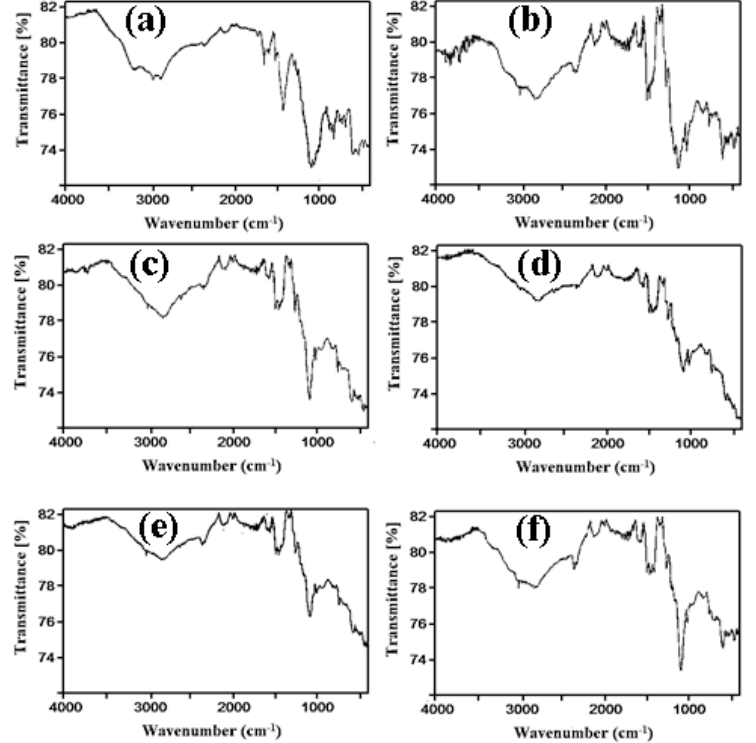
Figure 2. FTIR spectra of ( a ) pure POA, ( b ) 1% of POA/BaSO 4 , ( c ) 3% of POA/BaSO 4 , ( d ) 5% of POA/BaSO 4 , ( e ) 7% of POA/BaSO 4 , and ( f ) 10% of POA/BaSO 4 POA/BaSO 4 , ( e ) 7% of POA/BaSO 4 , and ( f ) 10% of POA/BaSO 4.